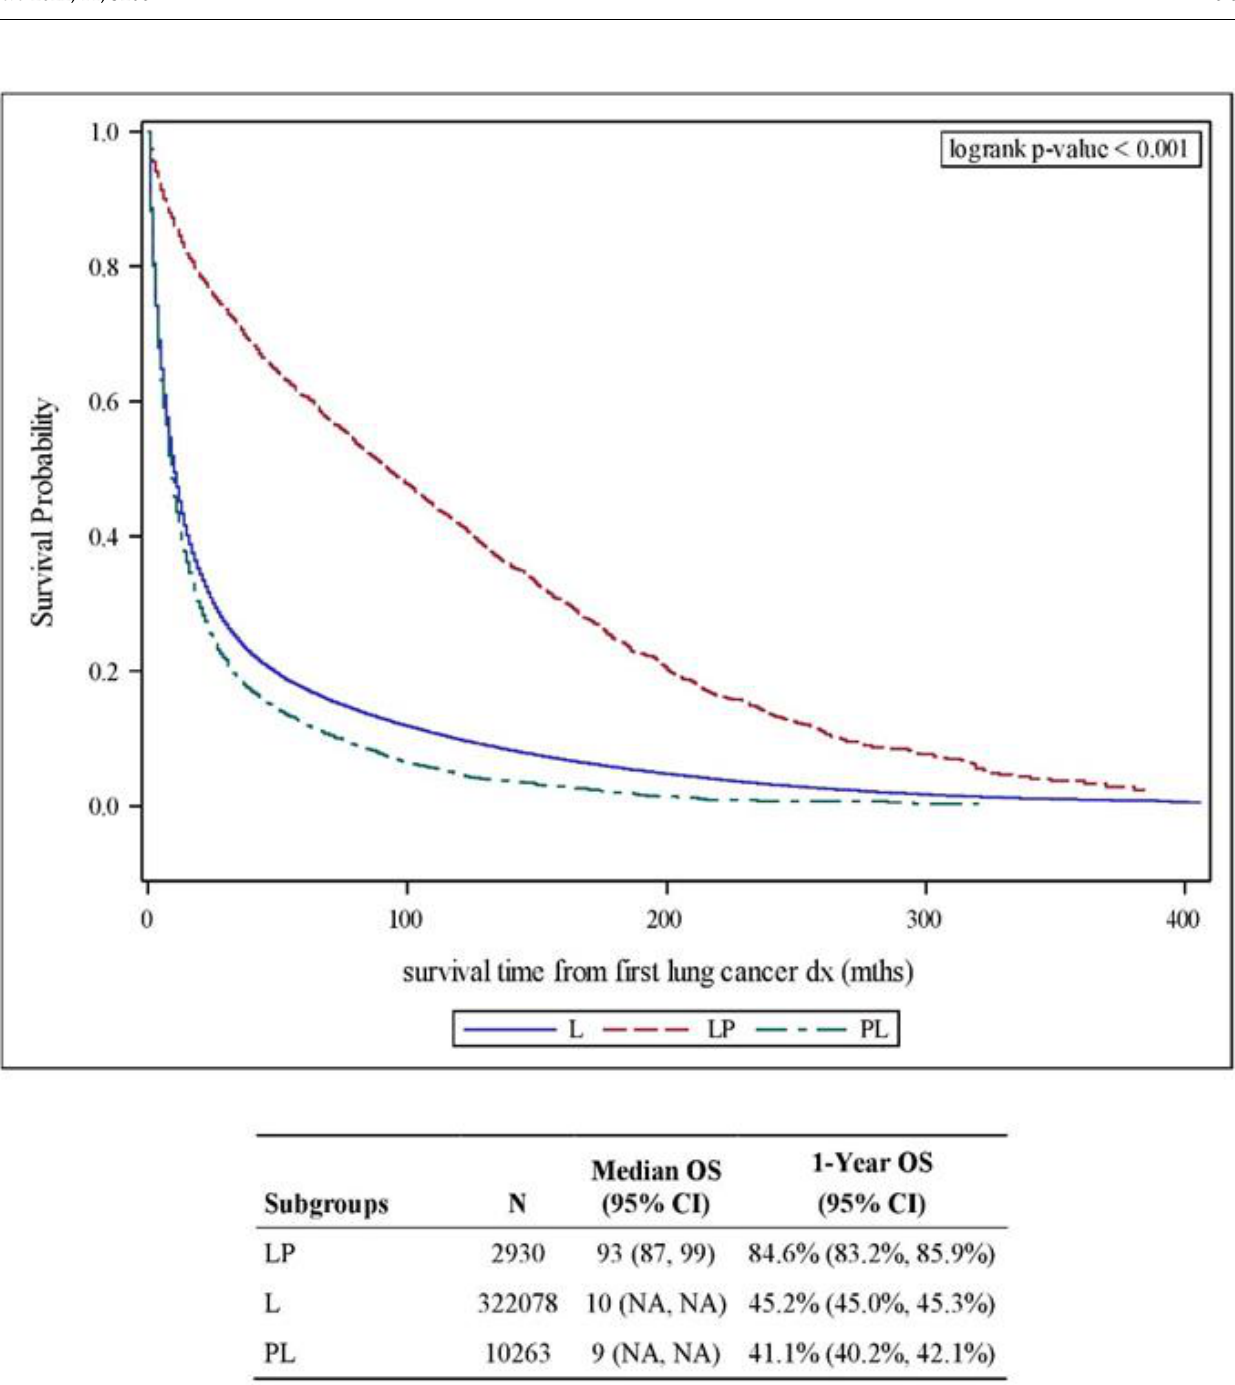
Figure 1. Kaplan–Meier plot for overall survival (OS) comparing the three subgroups, L, P-L and